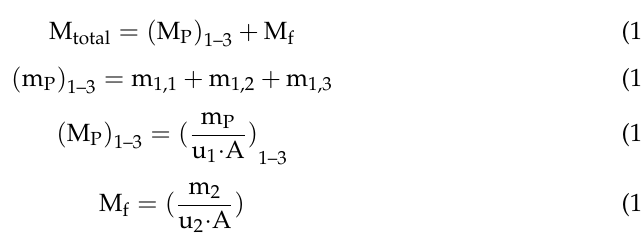
Figure 10. The evolution of particle deposition behavior over oil content.